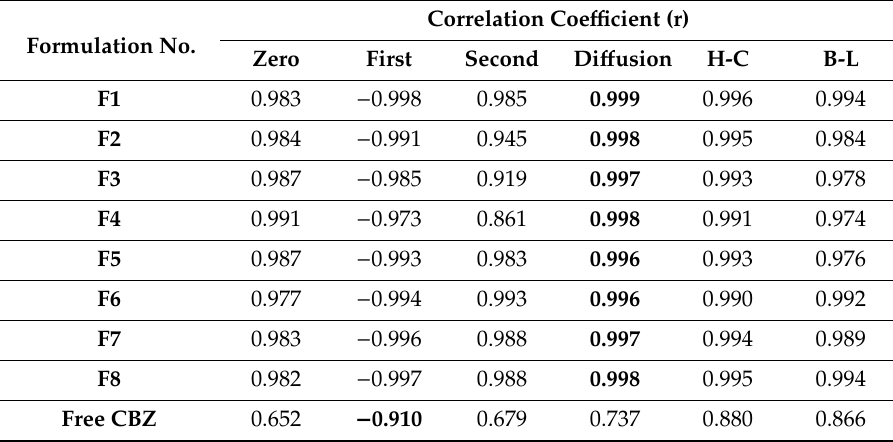
Table 3. The calculated correlation coe ffi cients for the in vitro release of carbamazepine employing di ff erent kinetic orders or